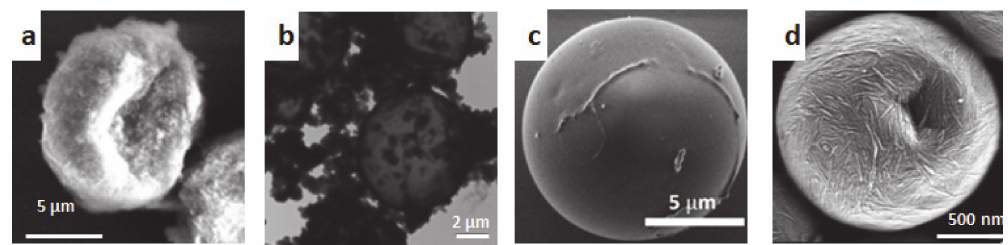
Figure 6. Examples of microcapsules stabilized by covalent bonds. ( a ) SEM imaging of a CNC − CoFe 2 O 4 microcapsule prepared by dissolution of the polystyrene core. Reprinted with permission from [153] Copyright (2014) American Chemical Society. ( b ) TEM images of polydopamine microcapsules